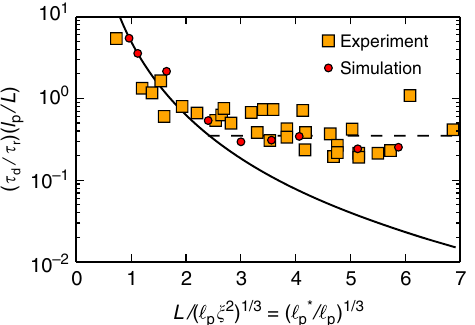
Fig. 5 Scaling of the rotational relaxation time for a tracer polymer in an array of frozen polymer chains. The numerical results for the rotational diffusion constant D r (cid:1) τ (cid:4) 1 in systems of different density and fl exibility, r